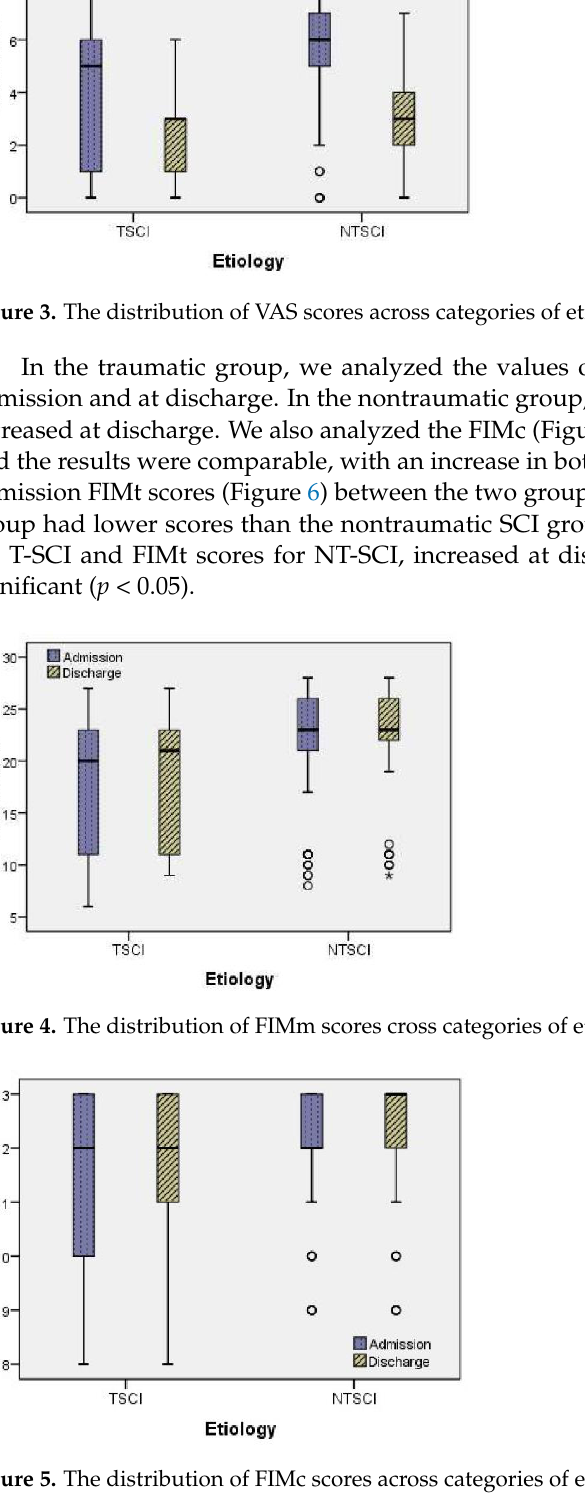
Figure 5. The distribution of FIMc scores across categories of etiology